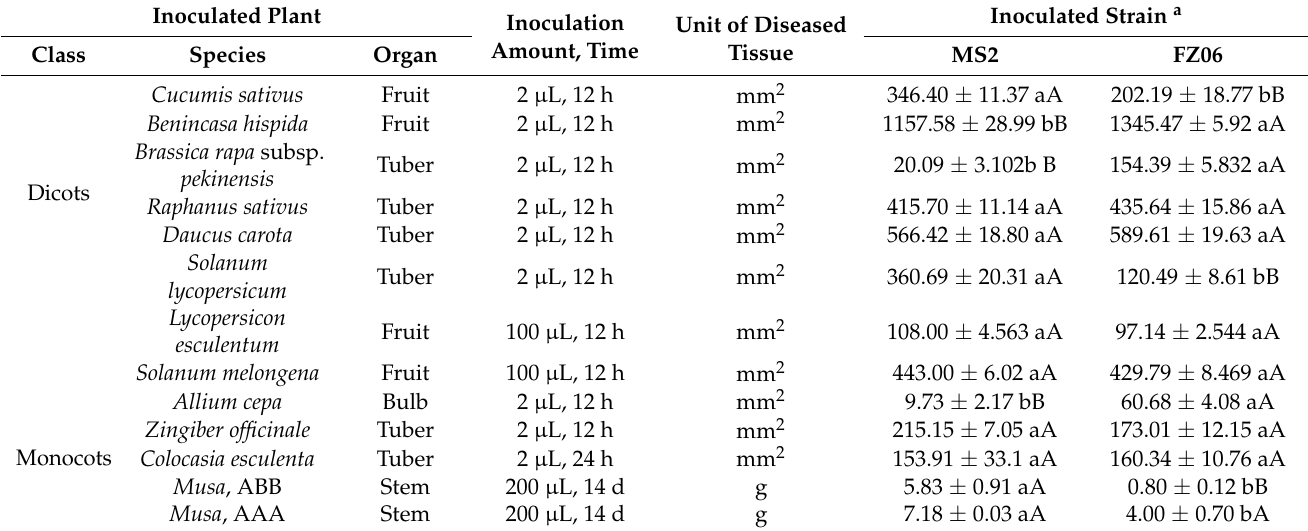
Table 1. Lesion sizes or weights on 13 dicotyledonous and monocotyledonous plants caused by strains FZ06 and MS2.